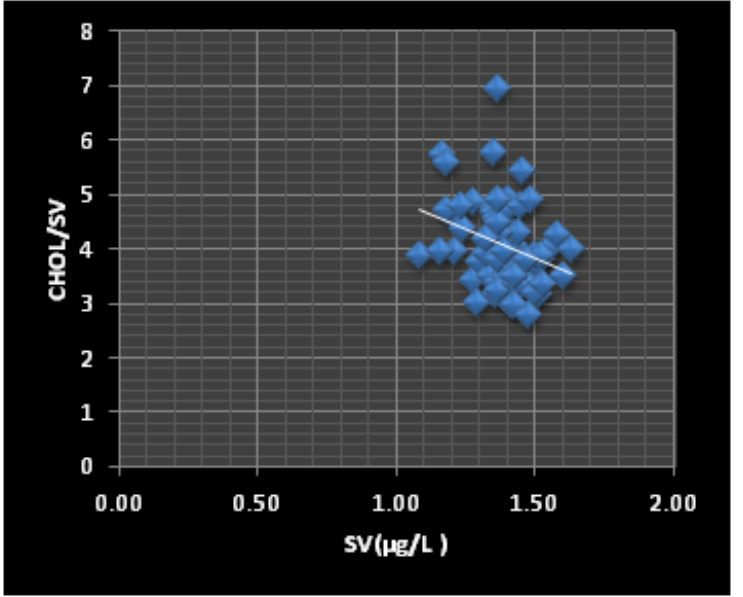
Figure 4. The correlation between the SV levels and the Chol/SV ratio (r = − 0.31, p = 0.0048) in the ThPP workers.